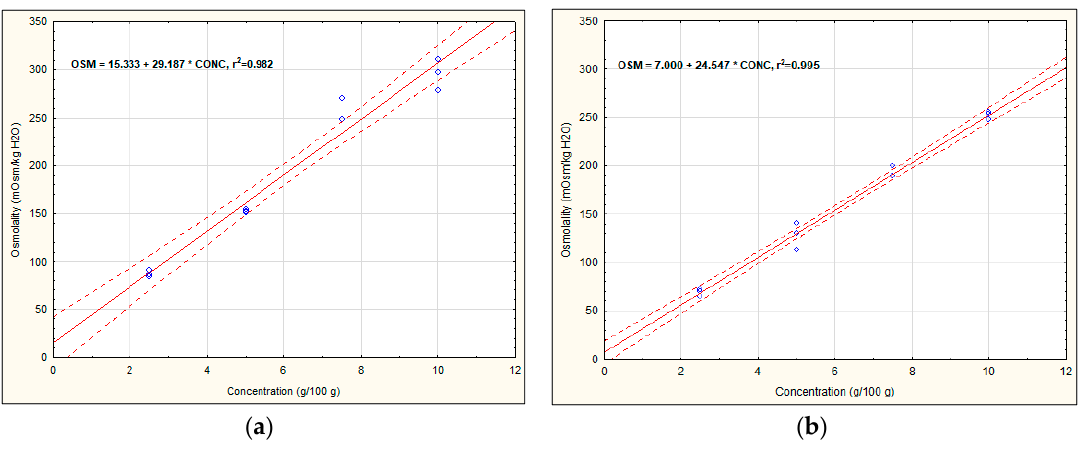
Figure 4. Blackcurrant freeze-dried ( a ) and spray-dried ( b ) powder osmolalities in aqueous solution.